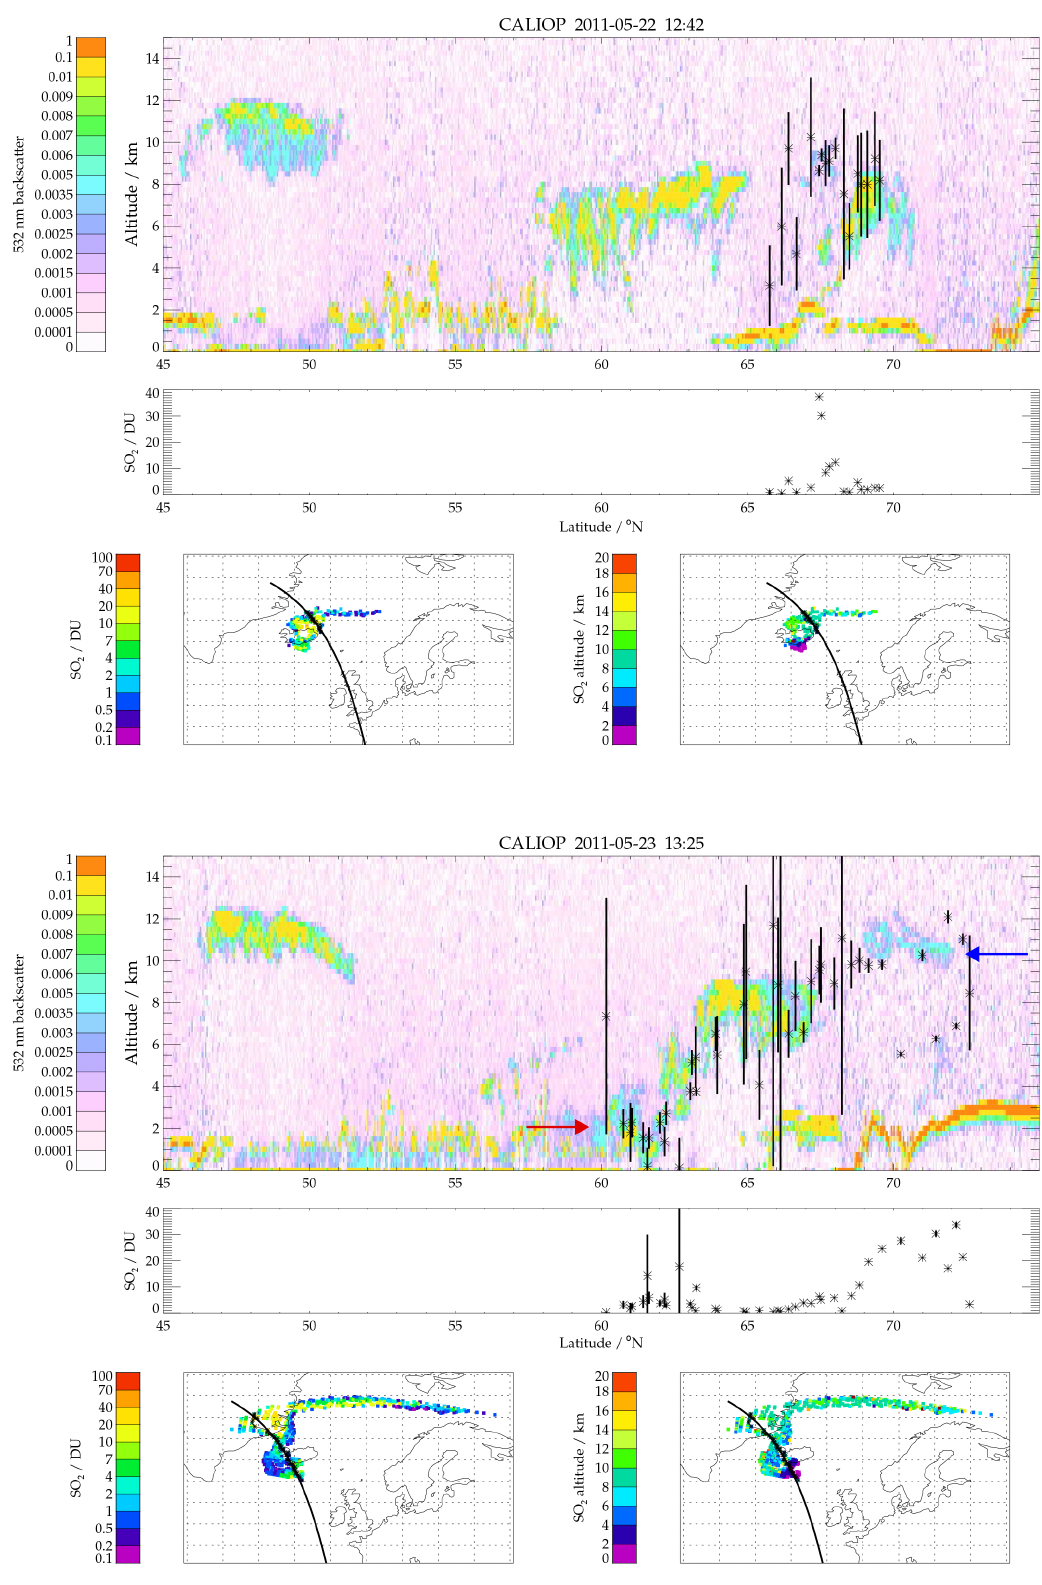
Figure 4. CALIOP/IASI coincidences for the Grímsvötn eruption on 22 and 23 May 2011. The blue arrow indicates the higher part of the plume; the red arrow indicates the lower part. As Fig.